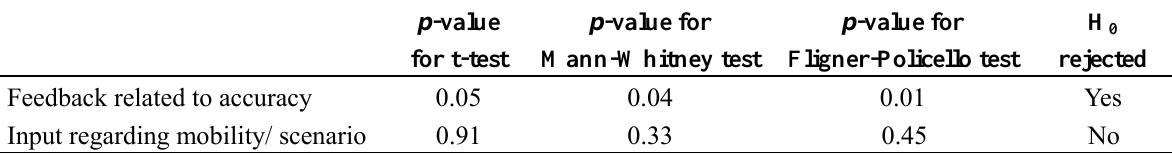
Table 6. Correlation between TUT and UPB groups regarding user interactivity level.